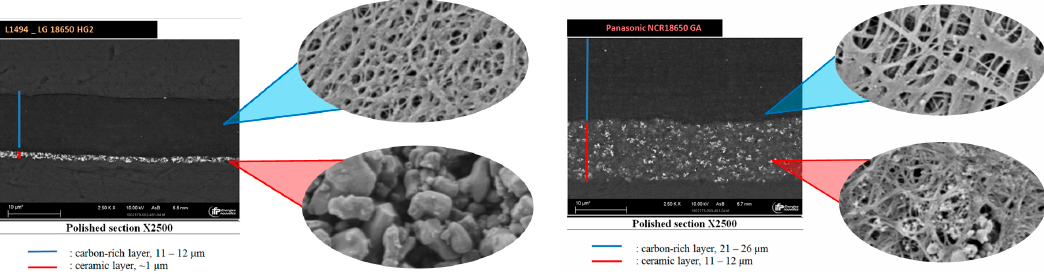
Figure 12. SEM images of LG HG2 ( left ) and Panasonic NCR GA ( right ) double-layer separators (results from the Physical Research and Analysis division of IFPEN, 2018).